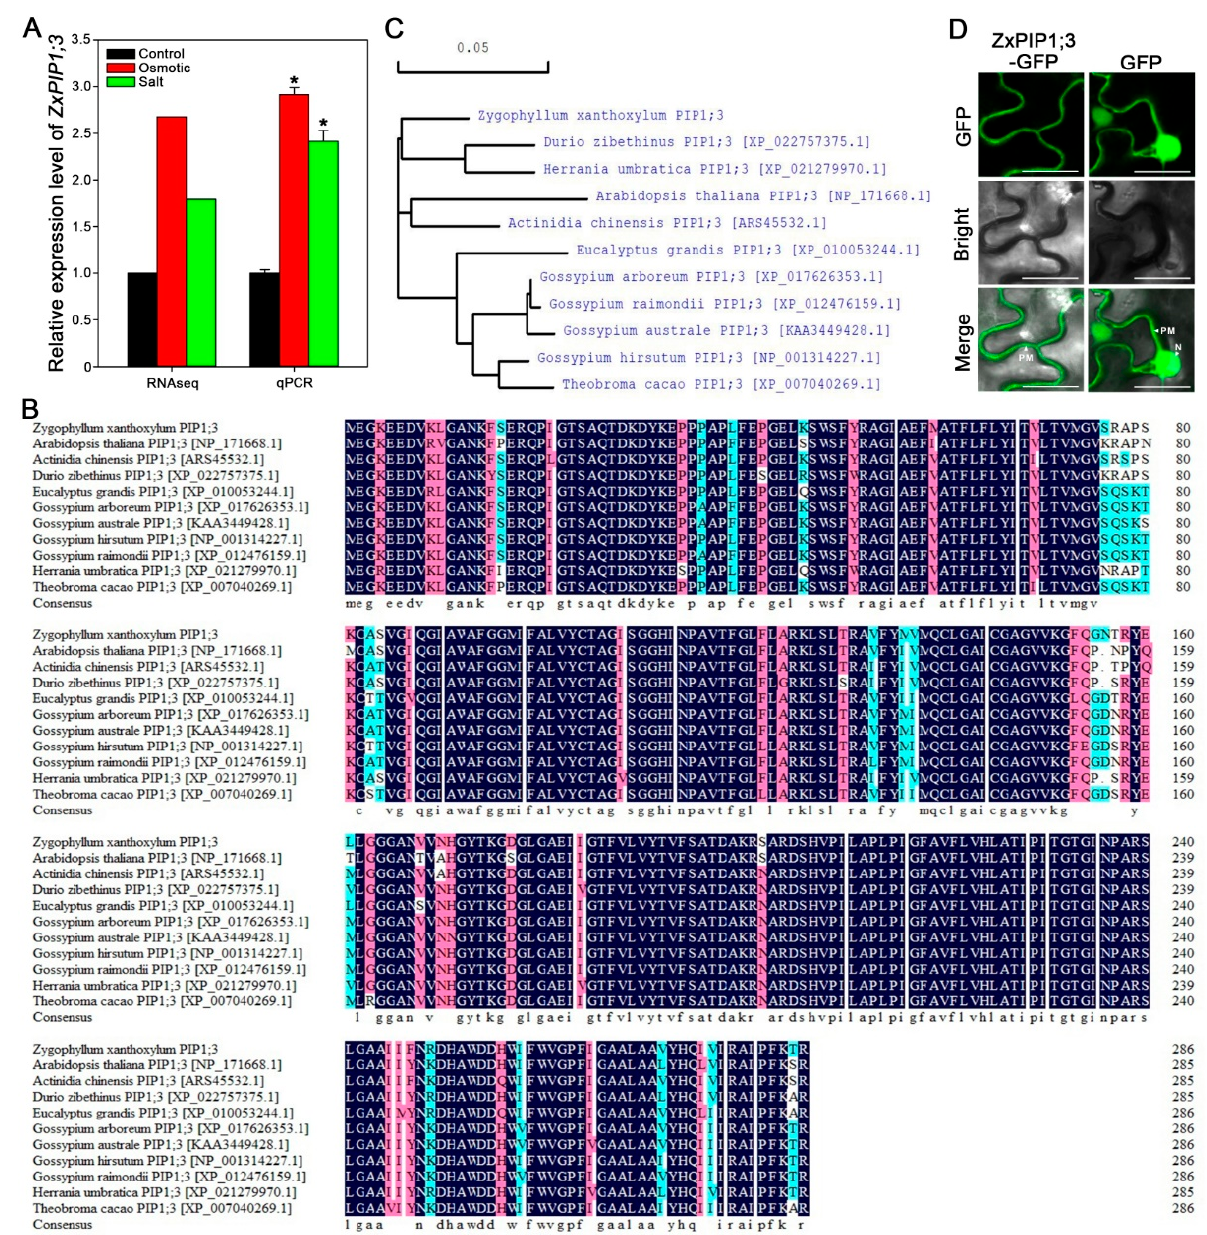
Figure 1. ZxPIP1;3 encodes a PIP1 protein whose expression level is related with osmotic and salt treatments. ( A ) qRT-PCR validation of RNA sequencing data in Z. xanthoxylum roots under osmotic stress or salt treatment for 6h. ( B , C ), alignment ( B ) and phylogenetic analysis ( C ) of ZxPIP1;3 with other known PIP1 proteins. Dark blue, pink and aqua indicate that the homology levels of these amino acids are 100%, more than 75% and more than 50% respectively. ( D ) Subcellular localization of ZxPIP1;3-GFP in epidermal cells of tobacco leaves. GFP driven by CaMV35S promoter served as control. PM, plasma membrane. N, nucleus. Green fluorescence represents GFP. Bar = 10 µ m. For ( A ), asterisks indicate significant differences from control condition. Data shown are means of three independent biological replicates (* p < 0.05, one way ANOVA).